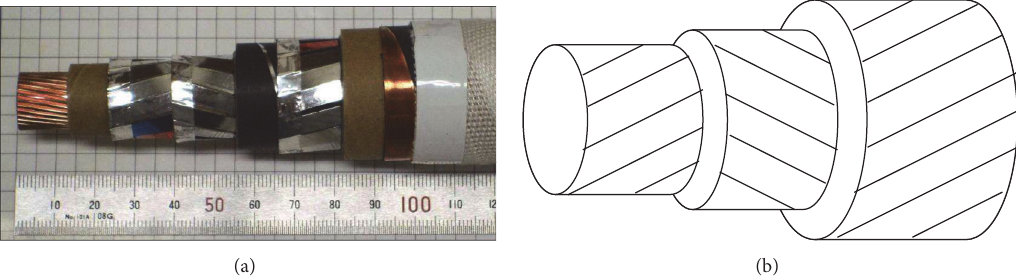
Figure 1: (a) A photo of the CASER-II power cable. (b) A schematic layout of the coaxial three-layer HTS conductor for the CASER-II cable.